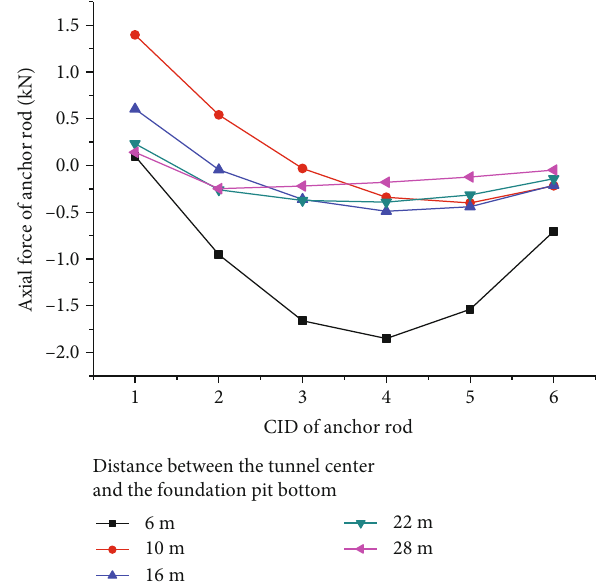
Figure 6: Axial force of the leftmost anchor bolt at di ff erent distances under the foundation